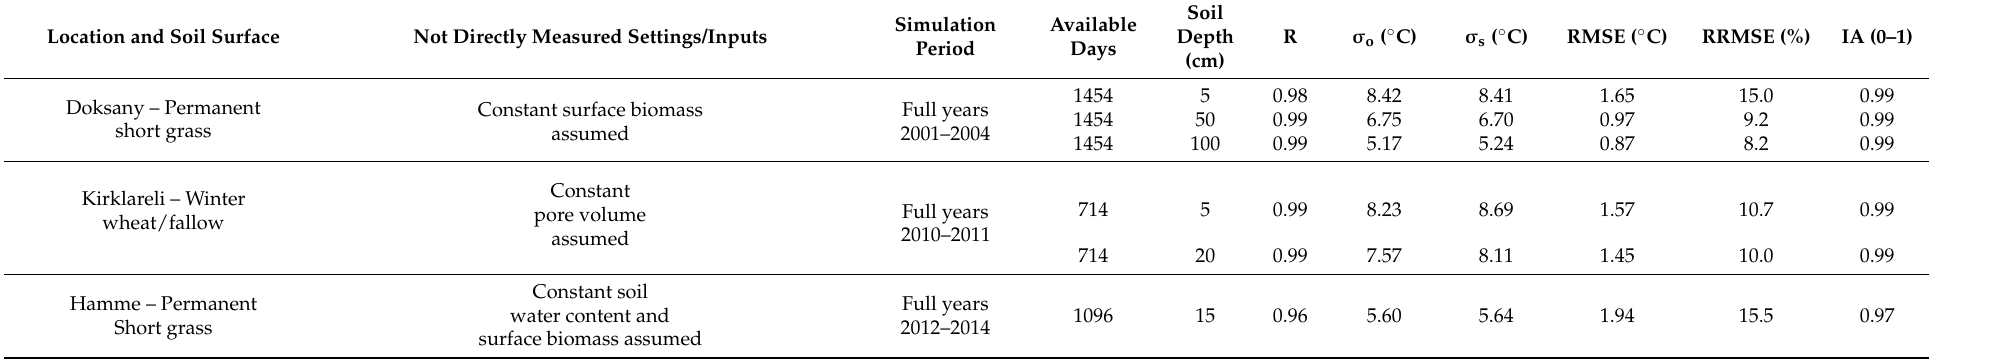
Table 7. Model validation results based on available data sets (see Table 1 for site characteristics). Location and Soil